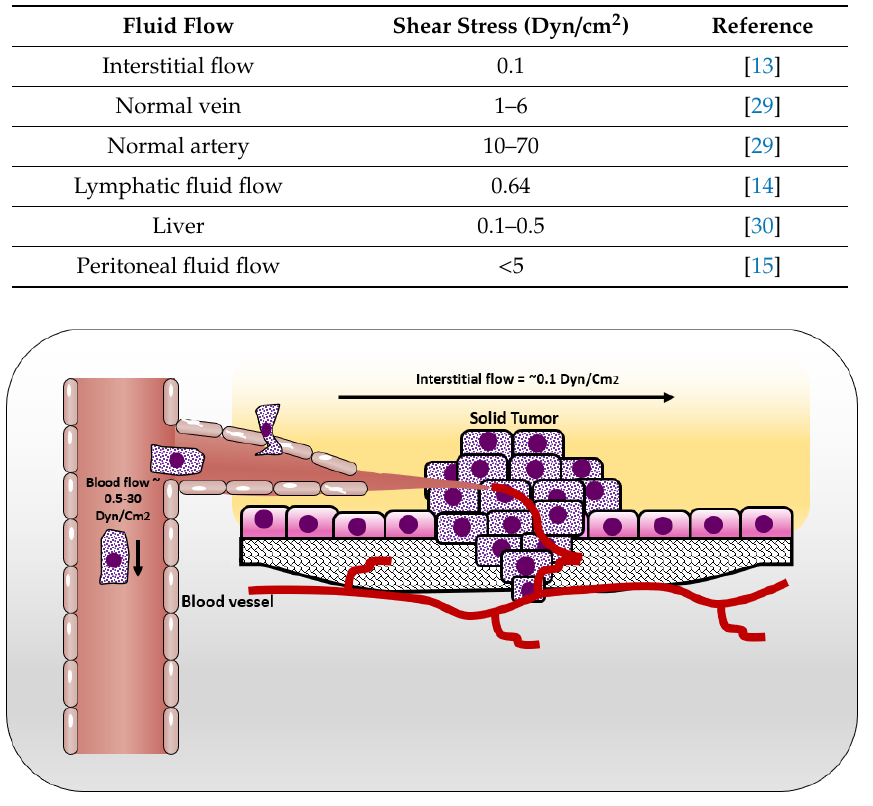
Figure 2. Shear stresses experienced by cells in solid tumor and circulating tumor cells.